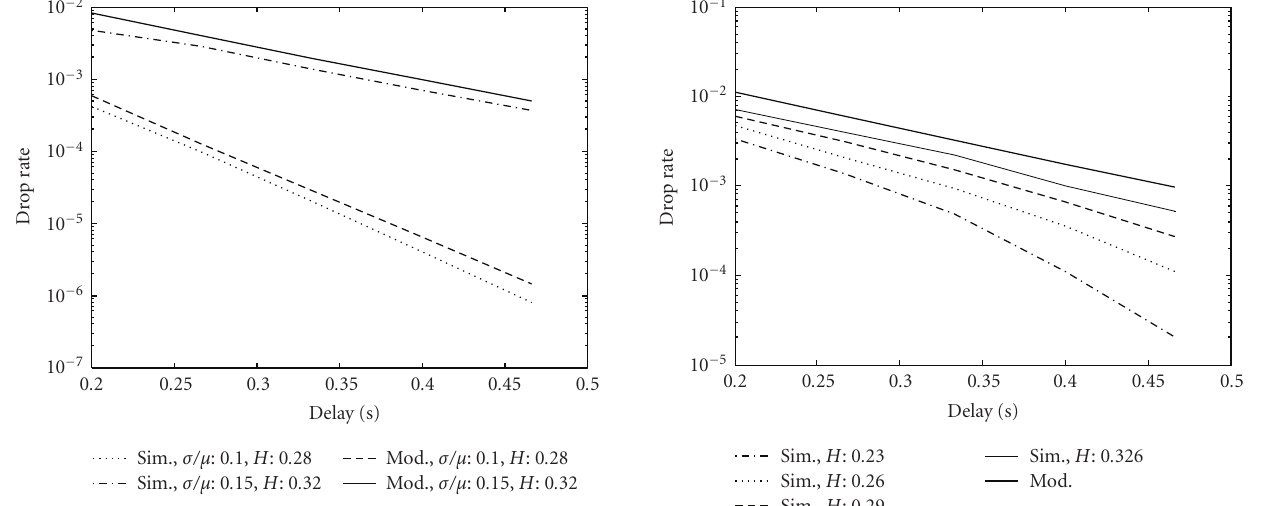
Figure 18: Data drop rate versus bu ff ering delay estimated by the model (Mod) and measured by simulation (Sim) for bit streams with di ff erent values for Hurst